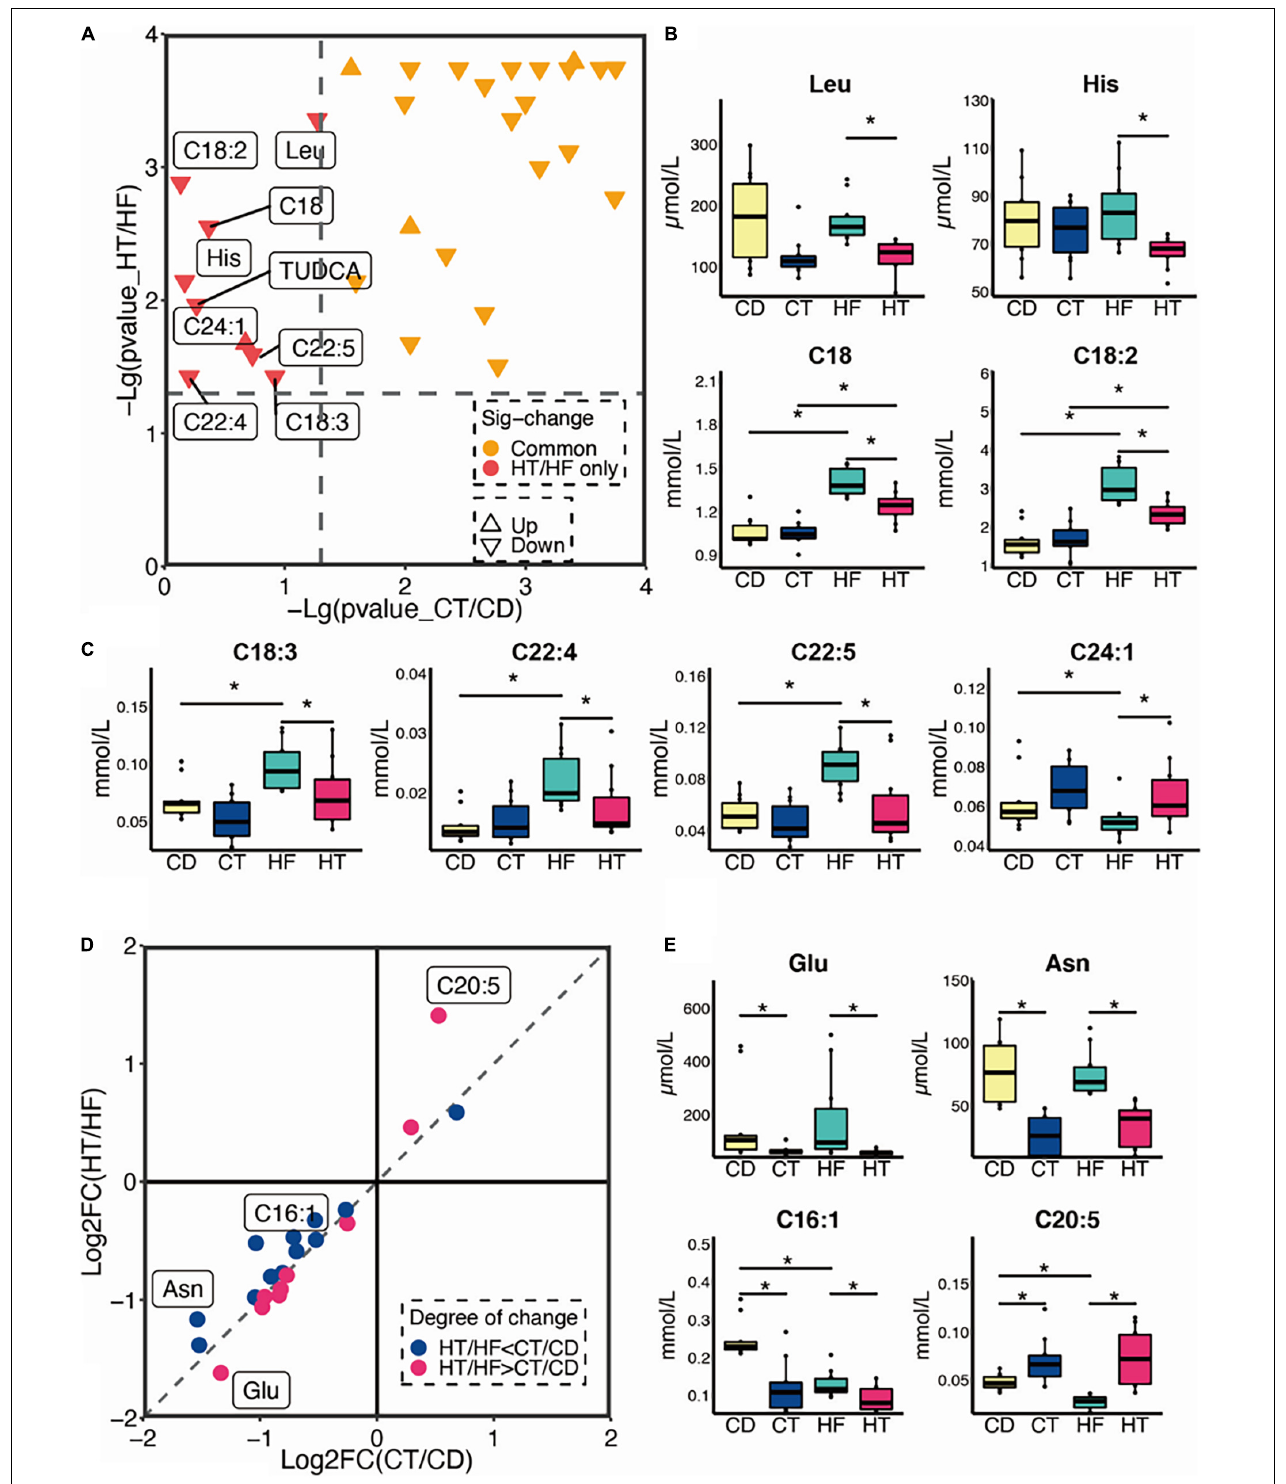
FIGURE 4 | Changes in metabolic patterns in CD and HF feeding mice after being treated with TNBS. (A) Distribution of significantly differential serum metabolites in comparisons of CT and CD and HT and HF ( n = 10). (B,C) The unique change of metabolites between the HT and HF groups rather than in the CT and CD groups. (D,E) The degree of change in common metabolites when compared with CT and CD and HT and HF. The Kruskal–Wallis ANOVA test was utilized to determine the significant difference in multiple groups. * p < 0.05. CD, control diet group; HF, high-fat diet group; CT, control diet and TNBS group; HT, high-fat diet and TNBS